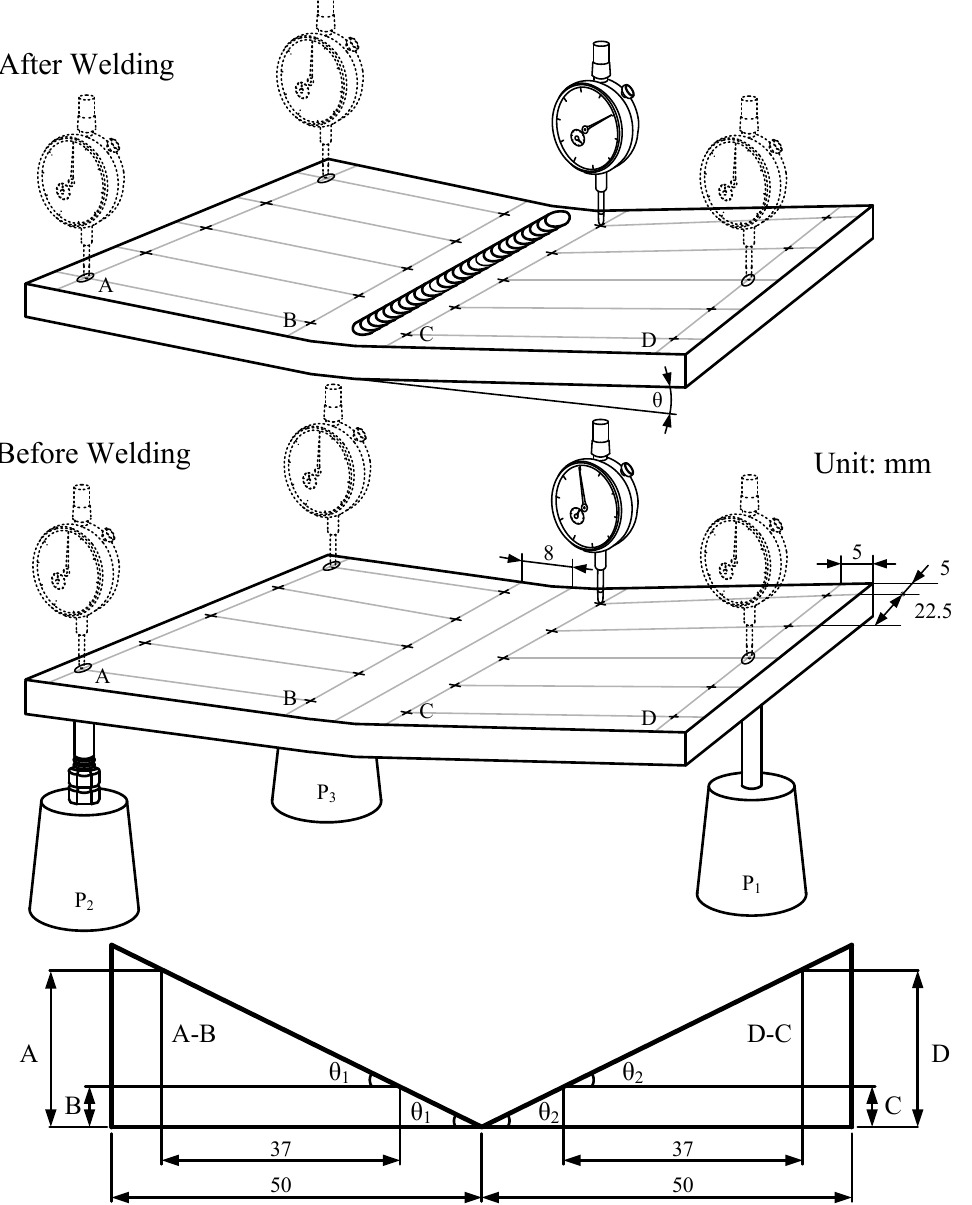
Figure 2. Measurement of angular distortion in bead-on-plate